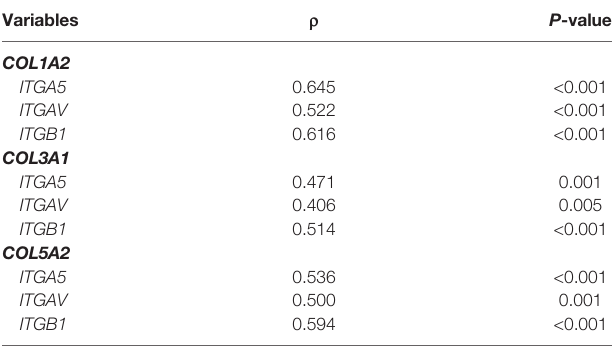
TABLE 3 | Correlation between COL and ITG gene expression in TME by non- parametric Kendall tau-b correlation coef fi cient (P<0.05). Variables